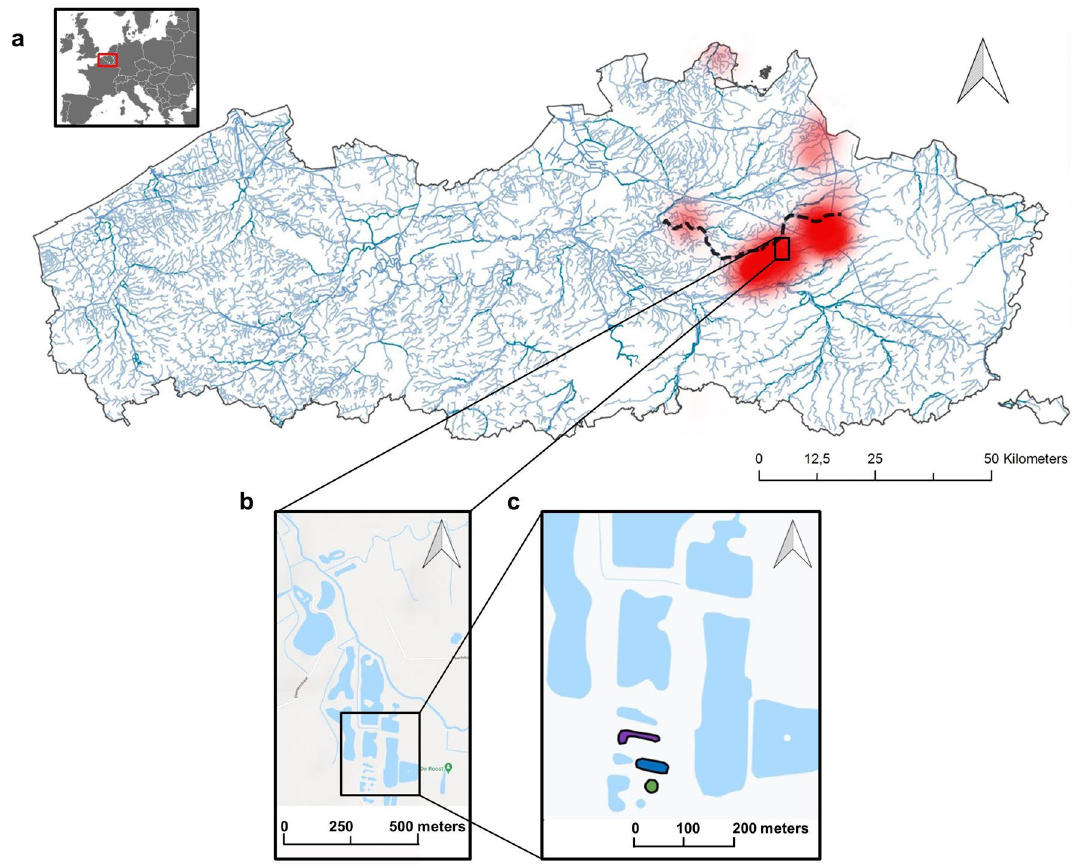
Figure 1. ( a ) A map of Flanders (Northern Region of Belgium, Western Europe) highlighting the contemporary bullfrog invasion in red (data derived from eradication campaigns and the open science data platform “waarnemingen.be”). The Grote Nete river is delineated by the black dotted line. ( b ) Location of nature reserve De Roost, where ( c ) the three permanent ponds were situated that were consecutively sampled for 21 months, highlighted in green (pond 1), blue (pond 2), and purple (pond 3). Maps were created in QGIS version 3.10.10 (https:// www. qgis. org/) using map data derived from than that of the Lin assay (5968.10 ± 589.7) (Fig. 3b), which was also the case for the mean resolution of the internal positive control (IPC) ( V 25 = 0.01, P < 0.001), resulting in a mean IPC resolution of 4928.31 ± 21.9 and 4855.77 ± 43.98 for the Goldberg and Lin assay, respectively (Fig. 3c). No positive target detection was obtained from each of the technical negative controls included in the workflow, while all positive reference samples were successfully amplified. Mesocosm experiment. No bullfrog eDNA was detected in the water used for the mesocosm experi- ment prior to the introduction of bullfrogs, nor from the technical negative ddPCR controls included in the workflow. Positive reference samples were successfully amplified. Although the mean number of accepted gen- erated droplets was 15,287 ± 167, three measurements fell below the threshold of 8000 generated droplets, and were consequently discarded. The target eDNA concentration in the mesocosms significantly increased with the abundance of bullfrog tadpoles and juveniles (tadpoles: F 6 = 1282.00, R 2 adj = 0.99, P < 0.001; juveniles: F 5 = 11.69, R 2 adj = 0.64 ; P = 0.019) (Fig. 4a,b) and total biomass (tadpoles: F 6 = 470.90, R 2 adj = 0.99, P < 0.001; juveniles: F